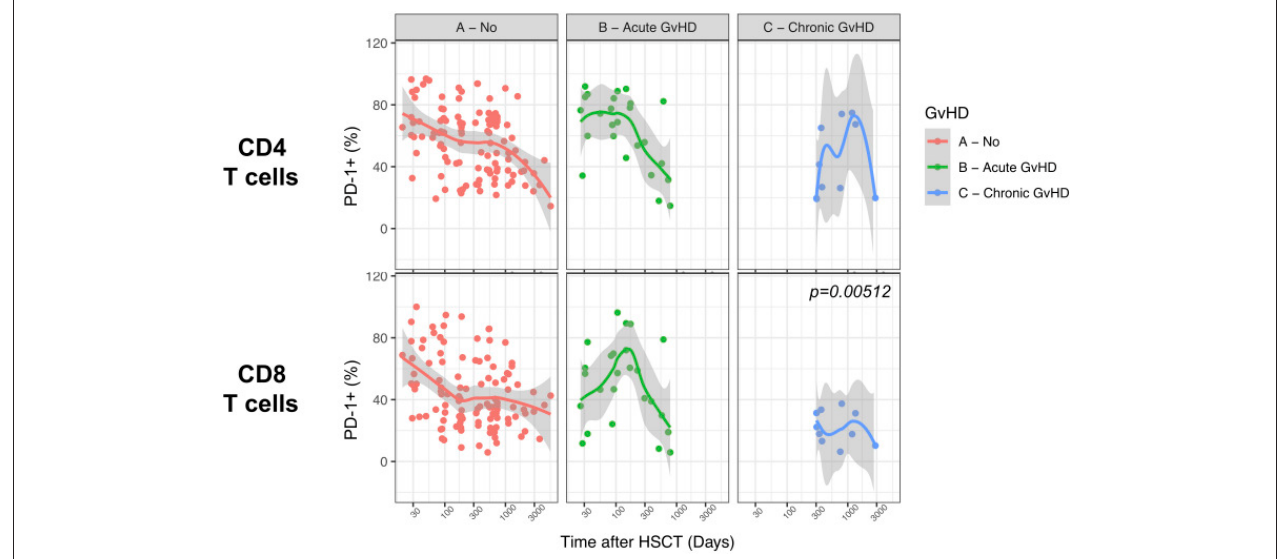
FIGURE 8 | Impact of acute and chronic GvHD on PD-1 expression on CD4 and CD8T cells after allogeneic HSCT. Comparison of PD-1 expression on CD4 and CD8T cells from HSCT recipients with no GvHD, acute GvHD or chronic GvHD. The p -values resulting from the multivariable linear regression analysis are indicated when